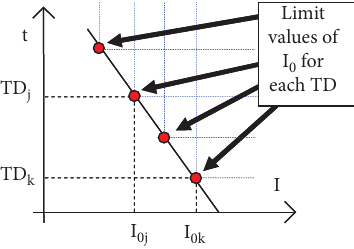
Figure 2: Example of values to be determined during the tests of the instantaneous and defnite-time functions